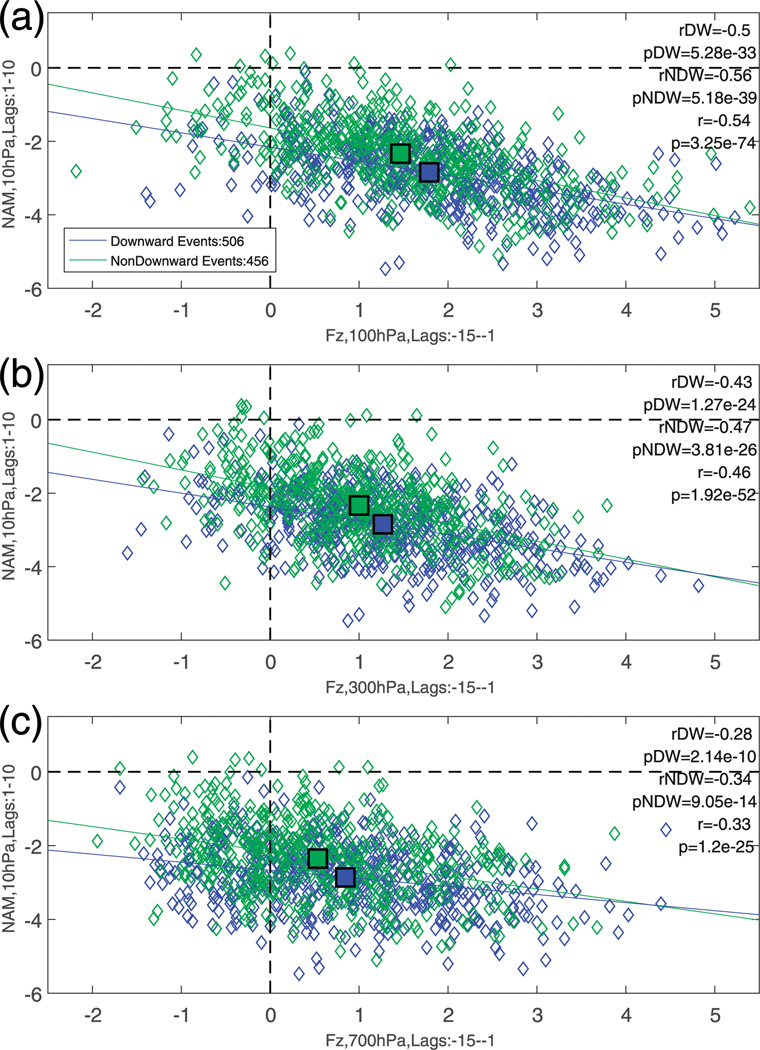
Scatterplots of standardized F(z) (filtered for wave 1) at (a) 100, (b) 300, and (c) 700 hPa, averaged over lags −15 to −1, against the NAM index at 10 hPa averaged over lags +1 to +10. Blue (green) diamonds, lines, and squares represent, respectively, individual DW (NDW) SSW events, the corresponding lines of best fit, and the overall composite averages. The rDW (pDW), rNDW (pNDW), and r (p) represent the correlation coefficients and p values for the DW events, NDW events, and total, respectively. The values in the top left show the numbers of DW and NDW SSWs that are preceded by such extreme wave activity averaged over lags −15 to −1.